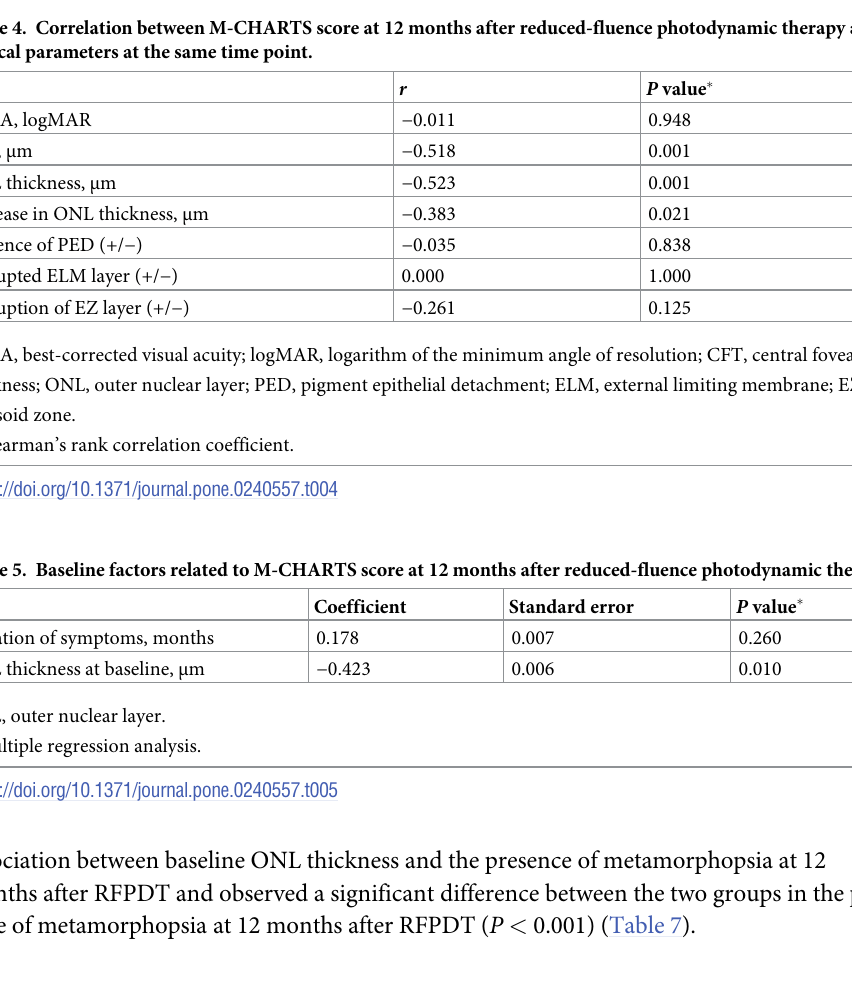
Table 3. Correlation between M-CHARTS score at 12 months after reduced-fluence photodynamic therapy and clinical parameters at baseline. r P value � Age, years 0.167 0.329 Duration of symptoms, months 0.457 0.005 PDT Spot size, μ m 0.112 0.528 BCVA, logMAR − 0.100 0.561 CFT, μ m − 0.212 0.214 Height of SRD, μ m − 0.236 0.167 Area of SRD, μ m 2 − 0.021 0.901 ONL thickness, μ m − 0.431 0.009 Elongated POS length, μ m 0.142 0.409 Presence of PED (+/ − ) 0.166 0.334 Disruption of ELM layer (+/ − ) - - PDT, photodynamic therapy; BCVA, best-corrected visual acuity; logMAR, logarithm of the minimum angle of resolution; CFT, central foveal thickness; SRD, serous retinal detachment; ONL, outer nuclear layer; POS, photoreceptor outer segment; PED, pigment epithelial detachment; ELM, external limiting membrane. � Spearman’s rank correlation coefficient.